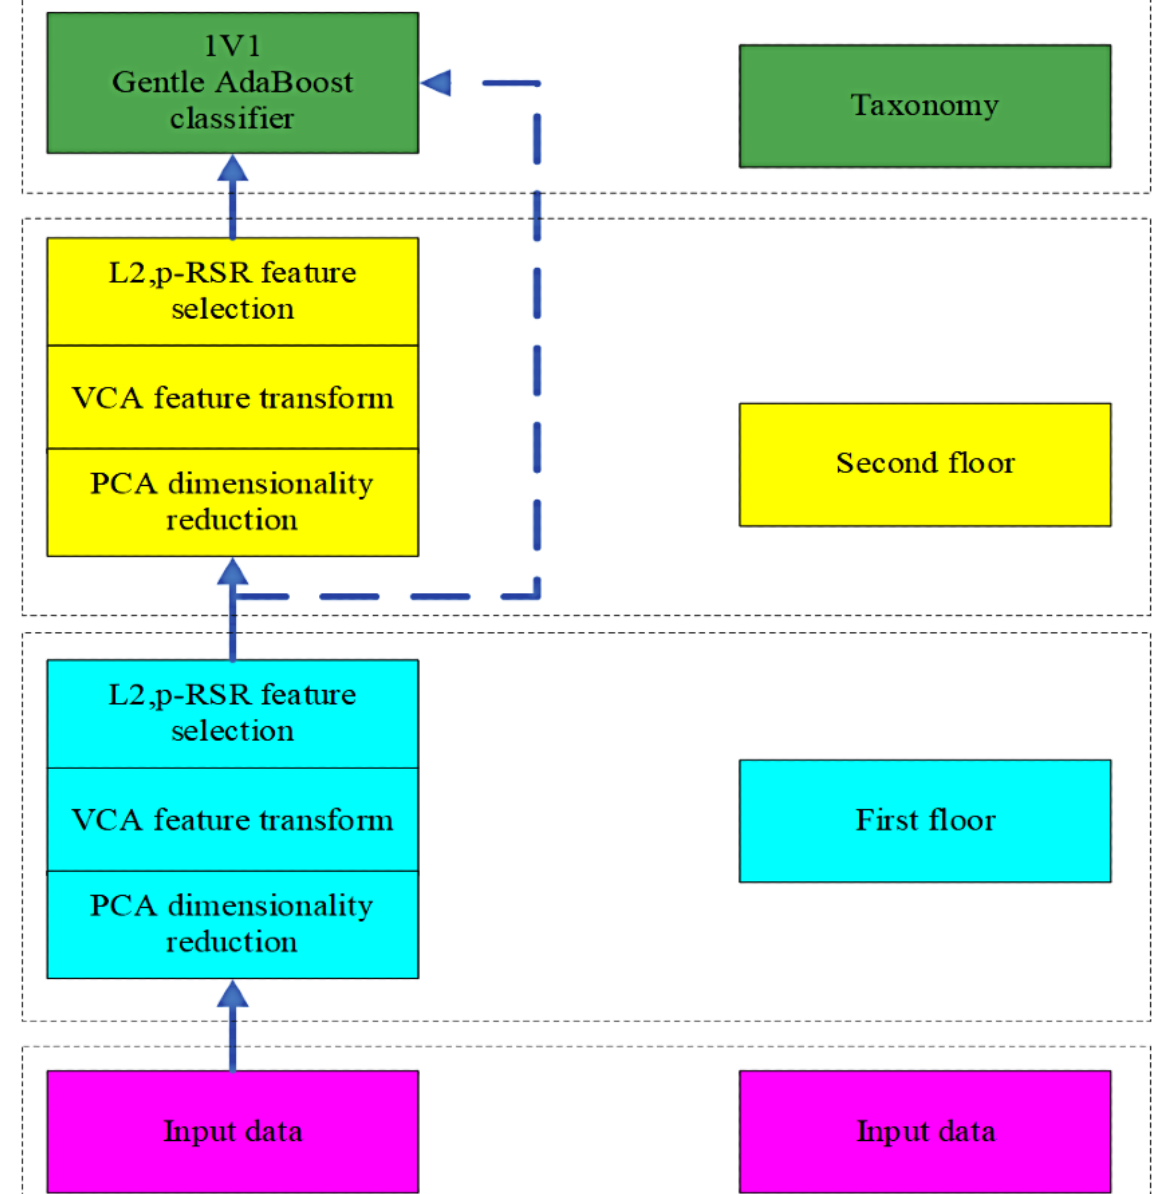
Figure 1. The cascaded deep learning framework. IVI: innovation value intuitive; AdaBoost: adaptive boost; PCA: principal component analysis; RSR: regularized self-representation; VCA: vanishing component